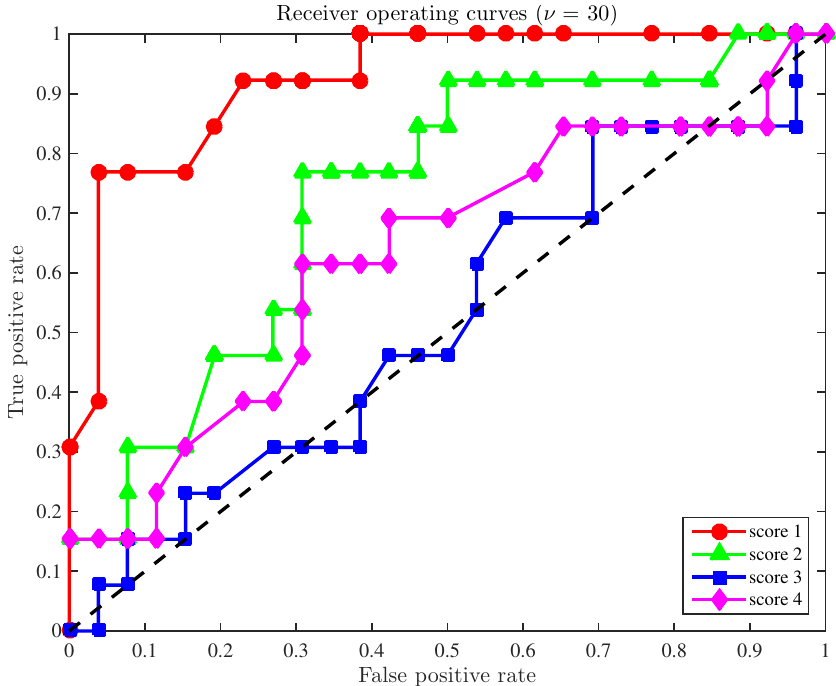
Figure 5. The ROCs for the four scores when the size of the samples to diagnose is ν = 30 and all the sensors are